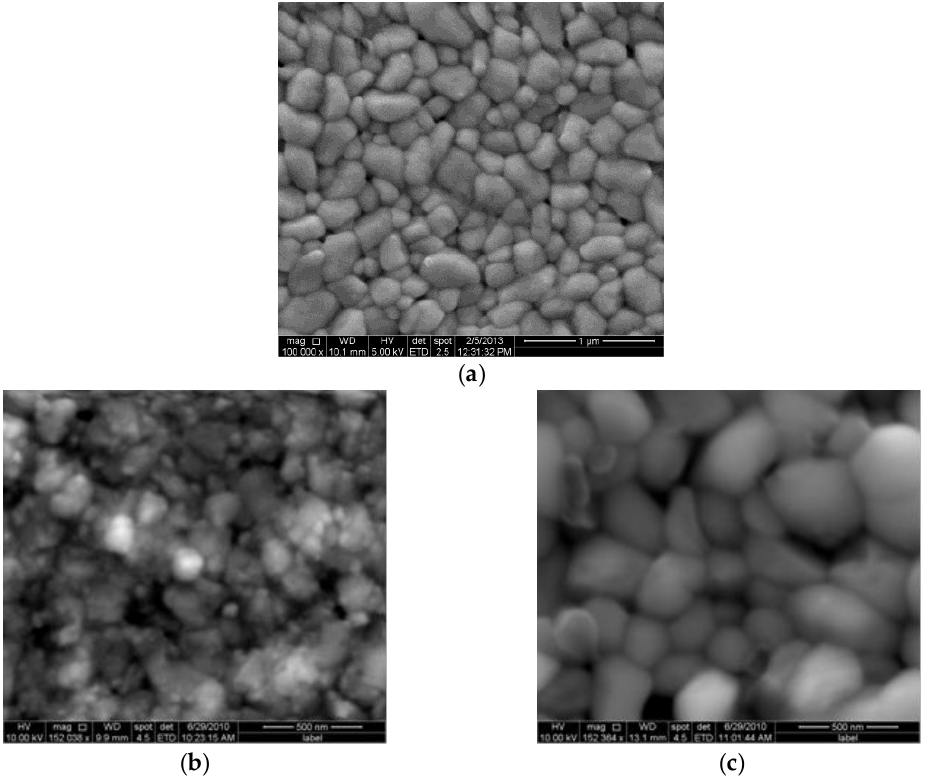
Figure 4. SEM images of a CdS:In thin film ( a ) [36], and two CdS 1−y Te y films with comparable thickness and different values of y; ( b ) y = 4.51 × 10 −2 , t = 720 nm; ( c ) y = 28.45 × 10 −2 , t = 620 nm. Note: The scale in ( a ) is 1 μm, and the scales in ( b , c ) are both 500 nm.